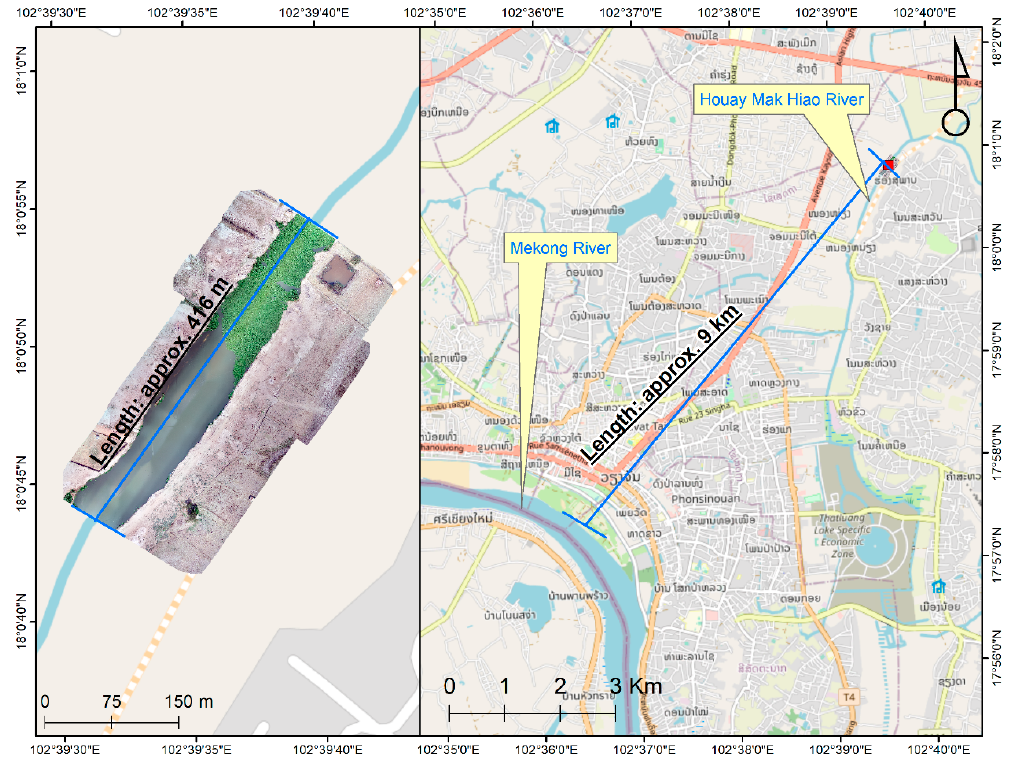
Figure 2. Study area showing Houay Mak Hiao River, Vientiane, Laos. (Background map: Open- StreetMap, 2021).